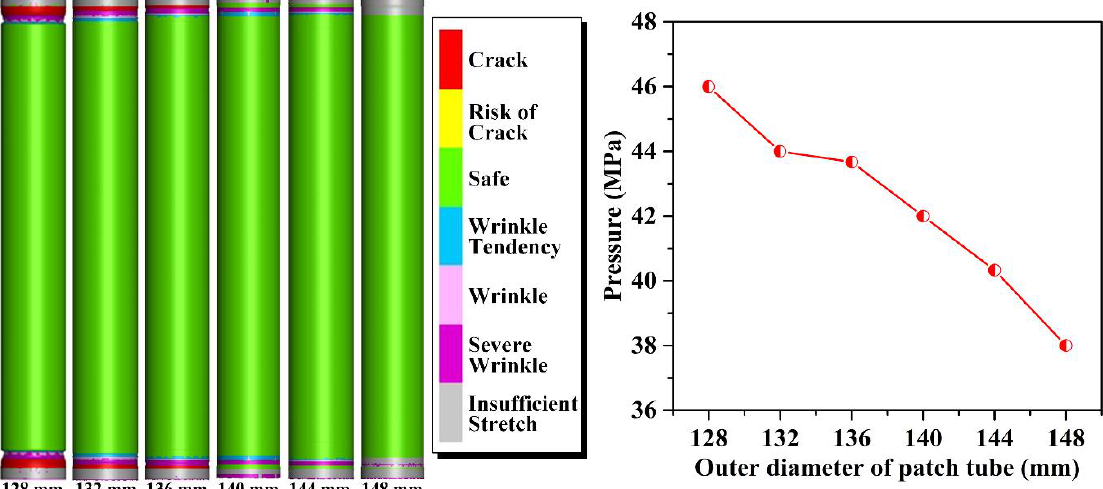
Figure 11. Influence of different outer diameters on forming pressure.